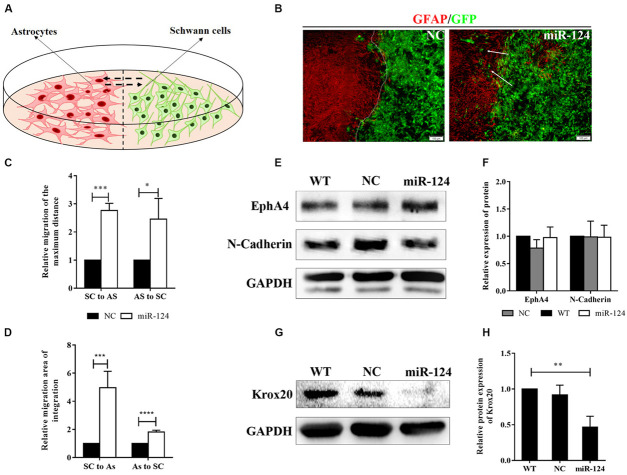
MiR-124 promoted in vitro integration of Schwann cells (SCs) and astrocytes (ASs). (A) A diagram for modeling the boundary assay for SCs and ASs. (B) The SC-AS integration was investigated by immunofluorescence. ASs were detected using anti-GFAP antibody (red), whereas SCs exhibited GFP (green) fluorescence. SCs migrated into astrocytic regions after miR-124 overexpression, while a sharp boundary formed between normal SCs and ASs. The white arrows indicate SCs migrating to ASs (scale bar = 100 μm). (C) The relative maximum distances of SC-AS migrating toward each other were both higher after miR-124 overexpression in SCs (n = 3, *p < 0.05, ***p < 0.001). (D) The relative migration areas of SCs and ASs were significantly higher after miR-124 up-regulation (n = 4, ***p < 0.001, ****p < 0.0001). (E,F) The expressions of EphA4 and N-Cadherin in SCs did not significantly change (n = 3, p > 0.05). (G,H) The expression of Krox20 in SCs was obviously lower after miR-124 overexpression (n = 4, **p < 0.01).